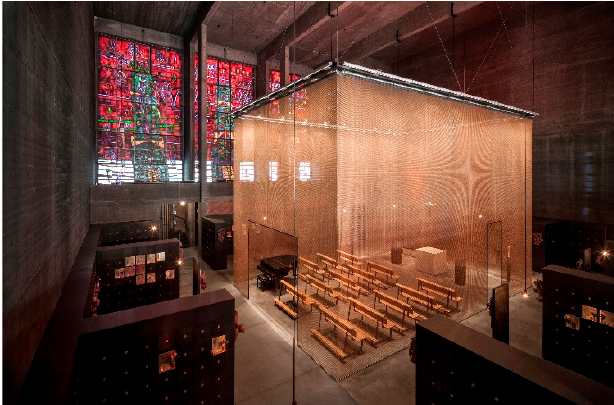
Figure 3. Grabeskirche St. Bartholomäus, Köln-Ehrenfeld (DE) 2014, design by Hans-Peter Kissler: the transformation of the interior is characterized by a central ceremonial place surrounded by columbarium walls with urn cases (photograph by Christian Schneider, © Grabeskirche Sankt Bartholomäus Köln).